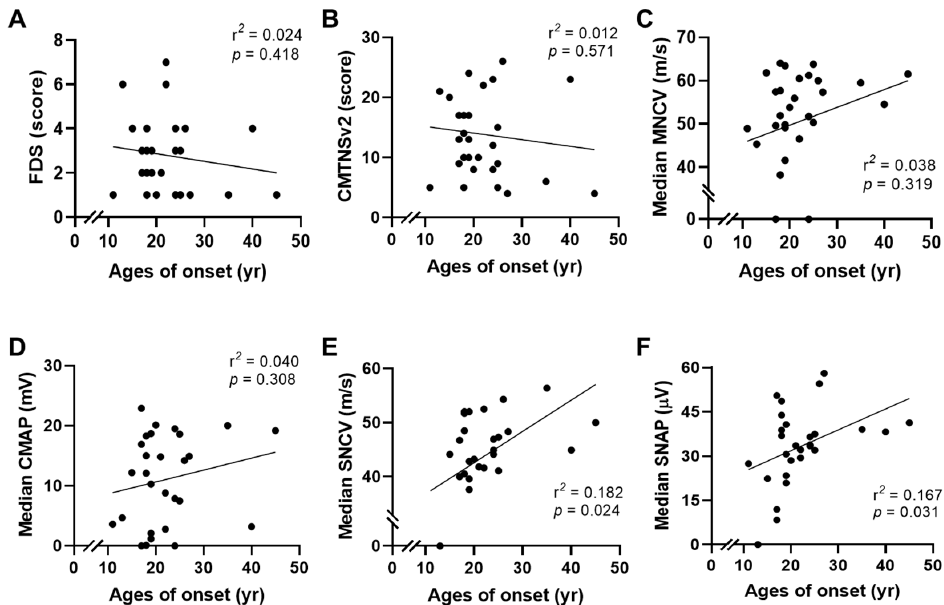
Figure 6. Correlation of clinical phenotypes according to onset ages (OA). ( A ) OA vs. FDS, ( B ) OA vs. CMTNSv2, ( C ) OA vs. median MNCV, ( D ) OA vs. median CMAP, ( E ) OA vs. median SNCV, and ( F ) OA vs. median SNAP.